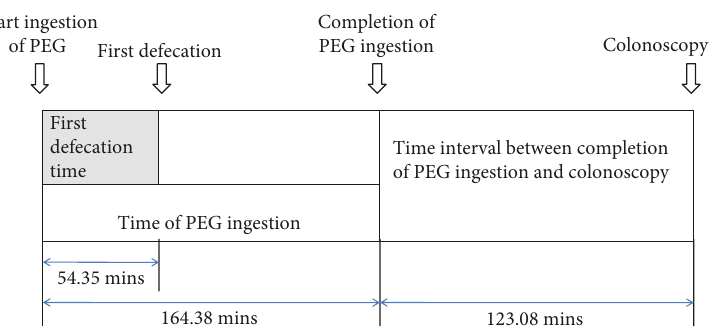
Figure 1: Summary of time intervals after PEG administration including the fi rst defecation